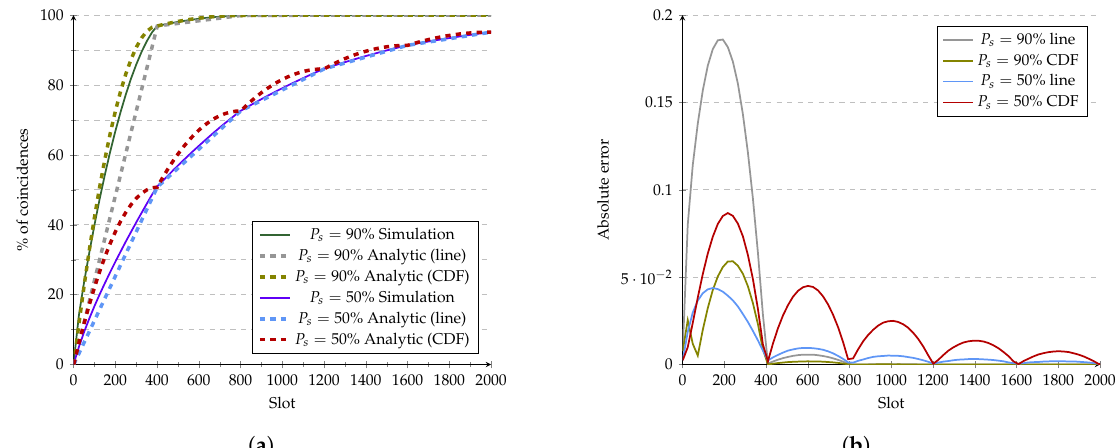
Figure 12. Evaluation of Quorum’s analytic model at 10% duty cycle. ( a ) Analytic model vs. simulations. ( b ) Error of the analytic model.